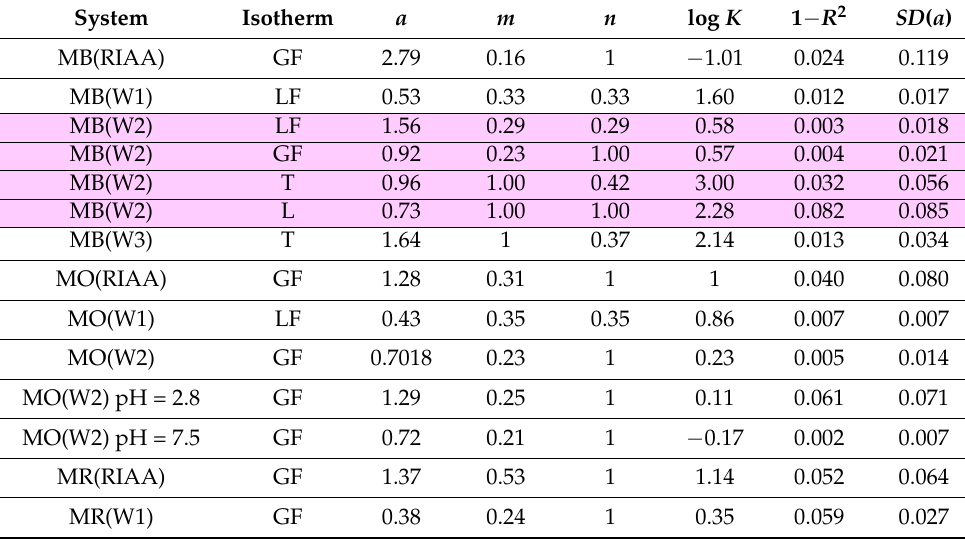
Table 3. The parameters of the Generalized Langmuir equation for the studied